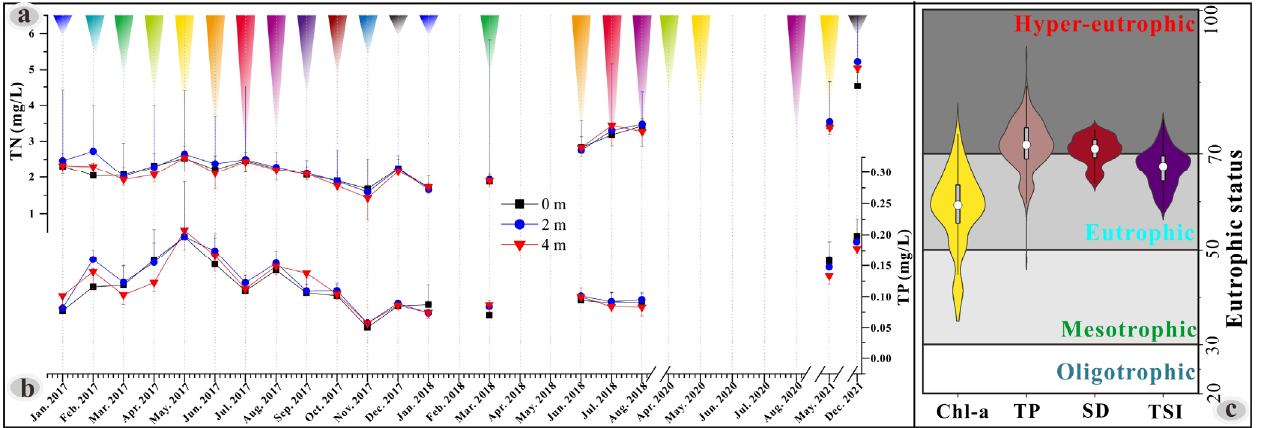
Figure 7. Seasonal and annual variations of TN and TP in Lake Qilu. ( a ) Seasonal and annual variations of TN; ( b ) Seasonal and annual variations of TP; and ( c ) the eutrophic status of Chl-a, TN, and TP.